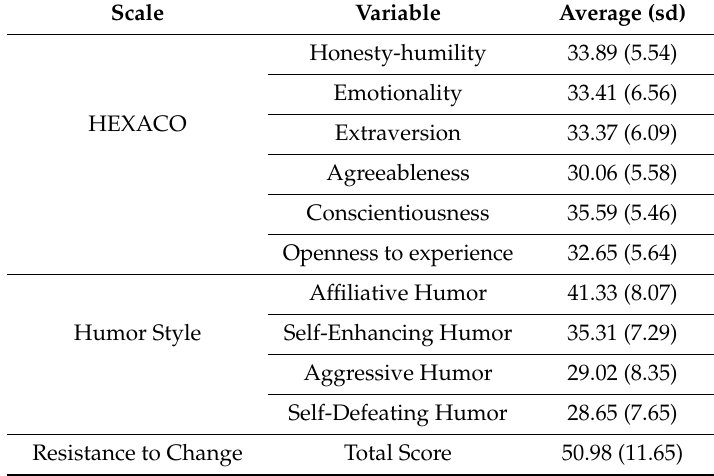
Table 1. Descriptive statistics for personality traits, humor style questionnaire’s dimensions, and resistance to change. The average and standard deviation is presented for each variable.